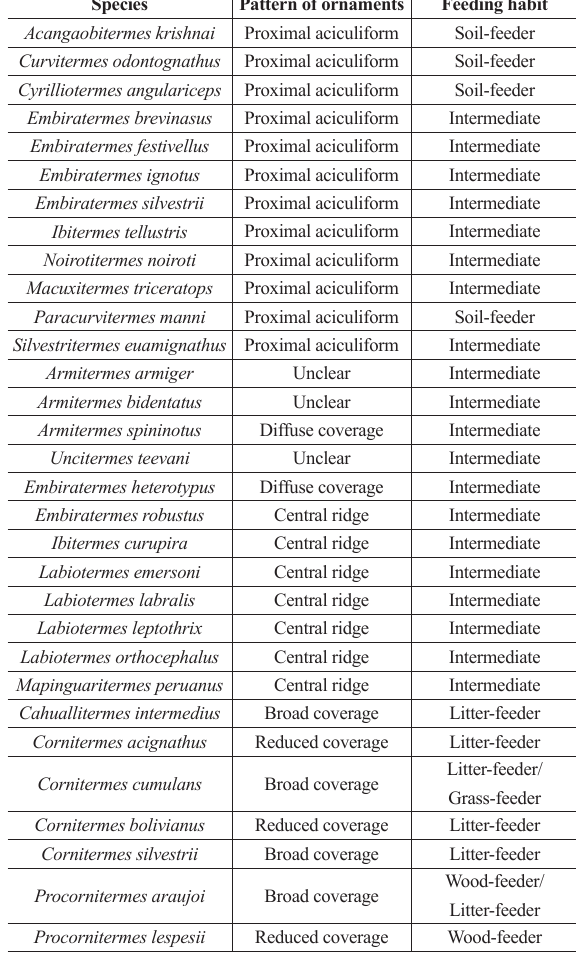
Table 2. Association between patterns of ornaments for the species studied, and their feeding